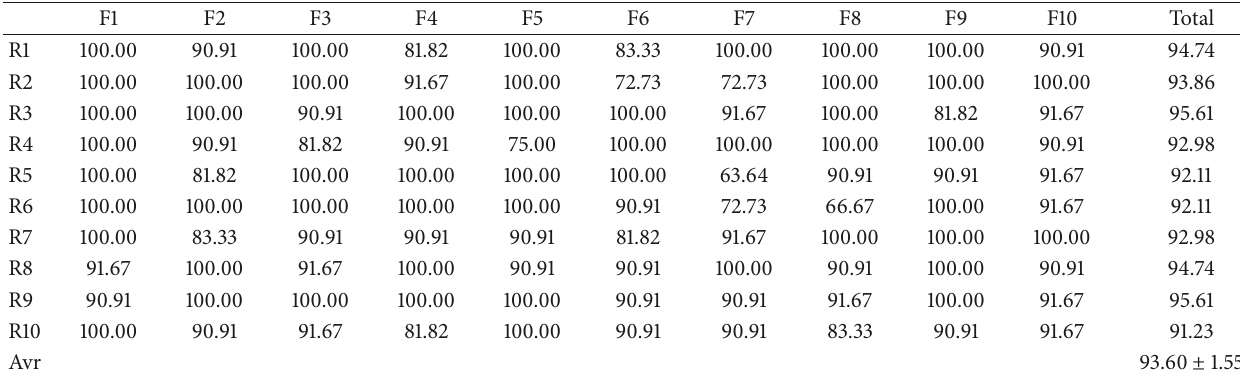
Table 3: Sensitivity of the proposed method (unit: %).